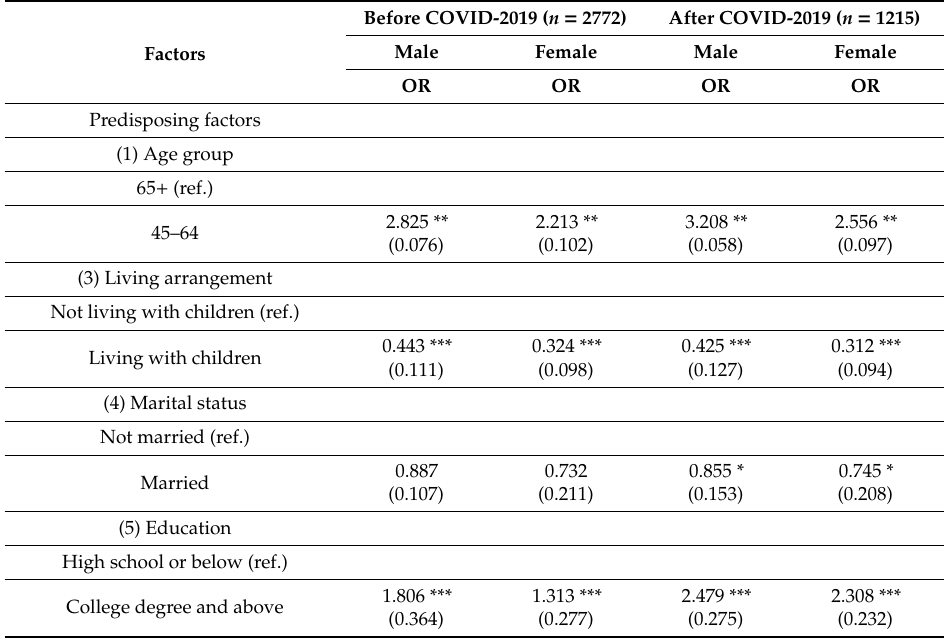
Table 3. Sub-multivariate analysis by